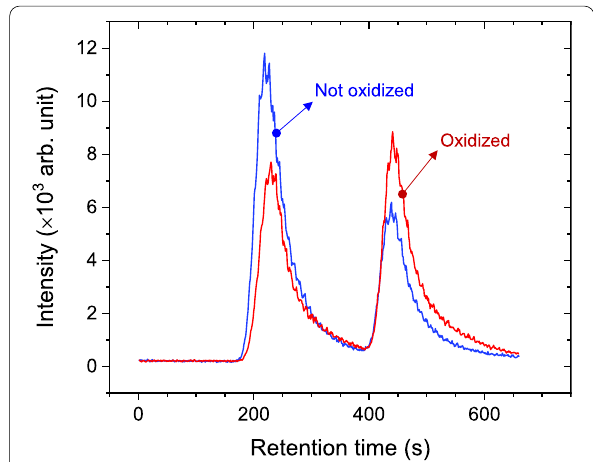
Fig. 2 Chromatograms of the non‑oxidized (blue) and oxidized (red) mixture solutions. In both mixture solutions, the concentrations of As from each species were equally set to 5 μg/kg